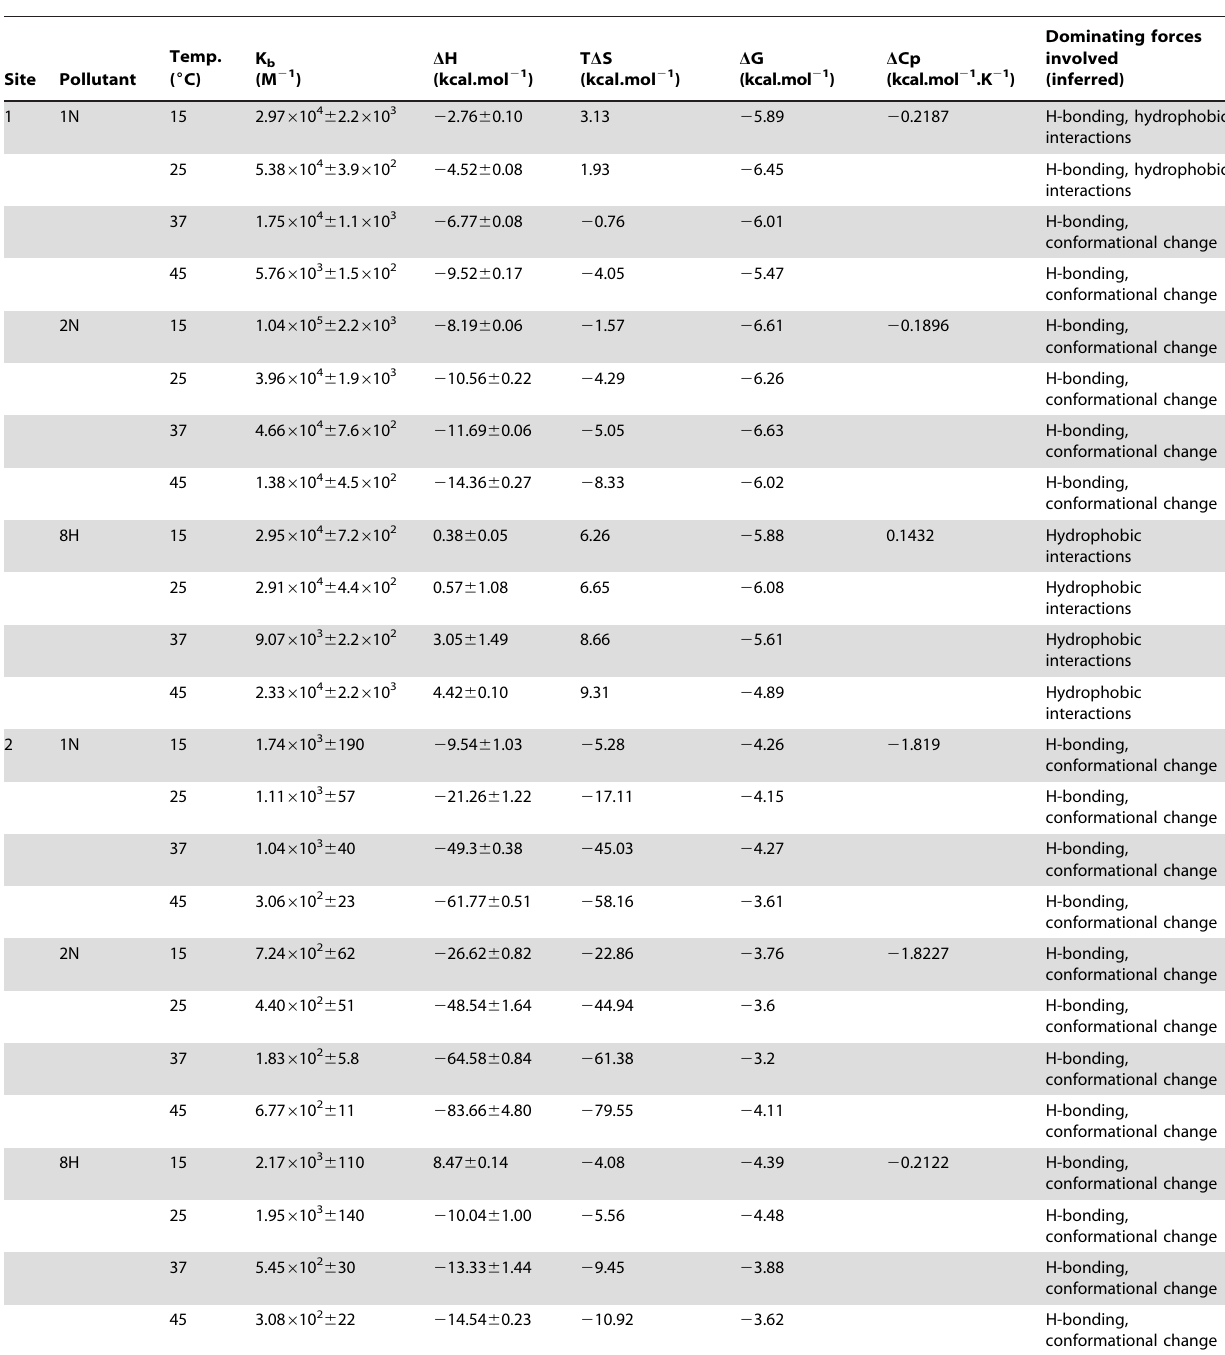
Table 6. Thermodynamic parameters of pollutants binding to HSA in 20 mM Tris-HCl pH 7.4 obtained and calculated by ITC data.